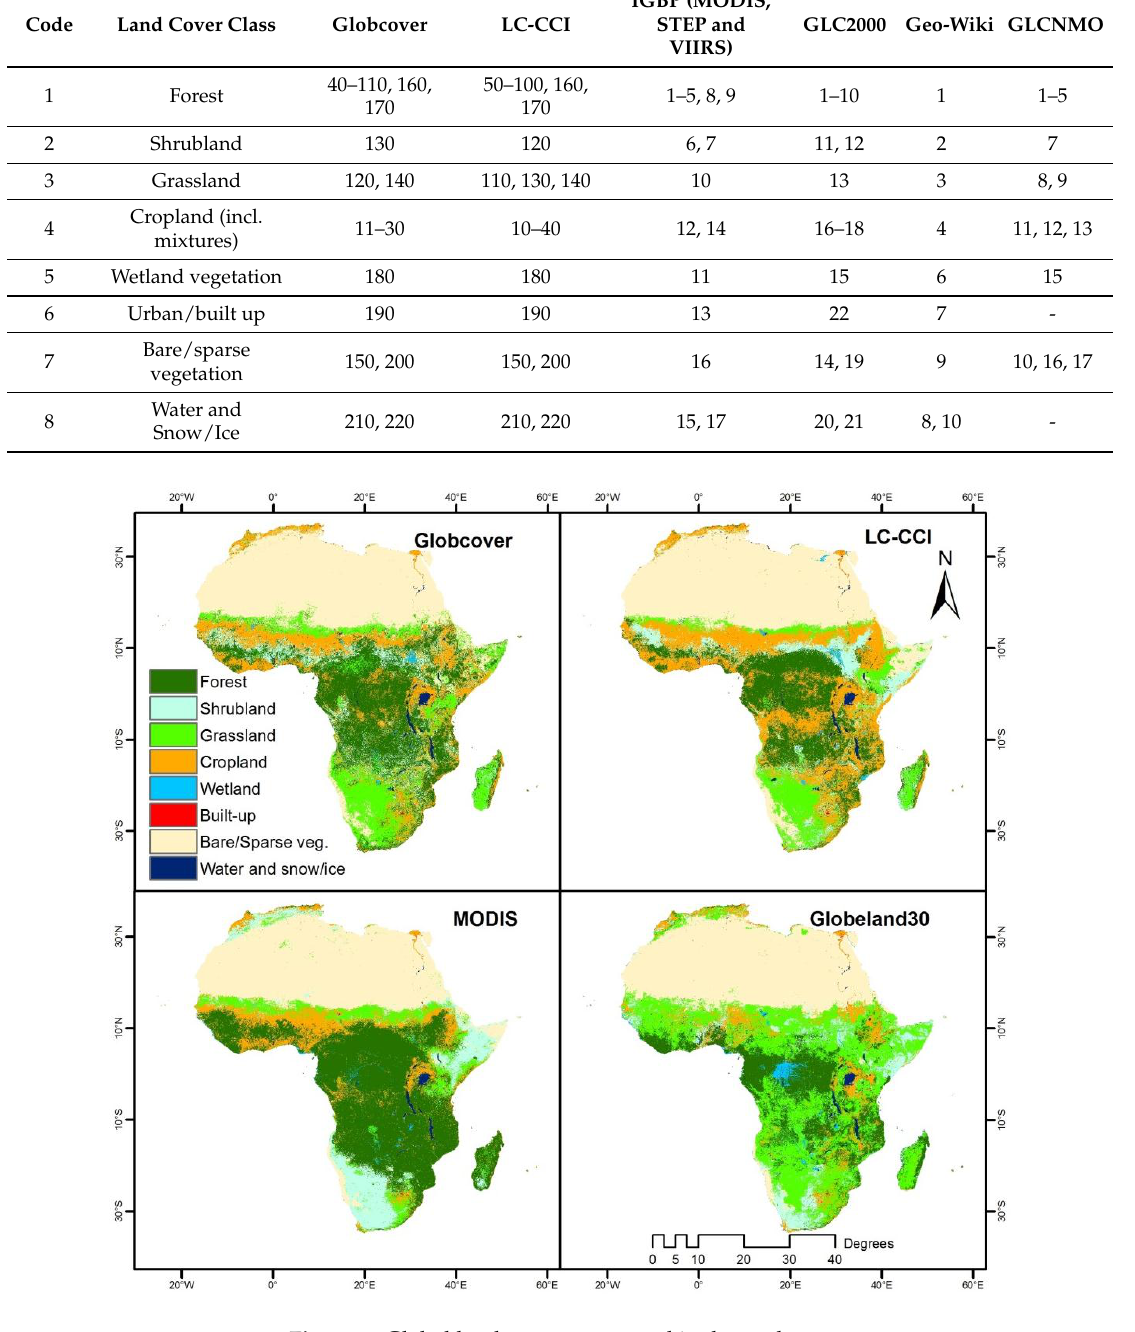
Figure 1. Global land cover maps used in the analyses.